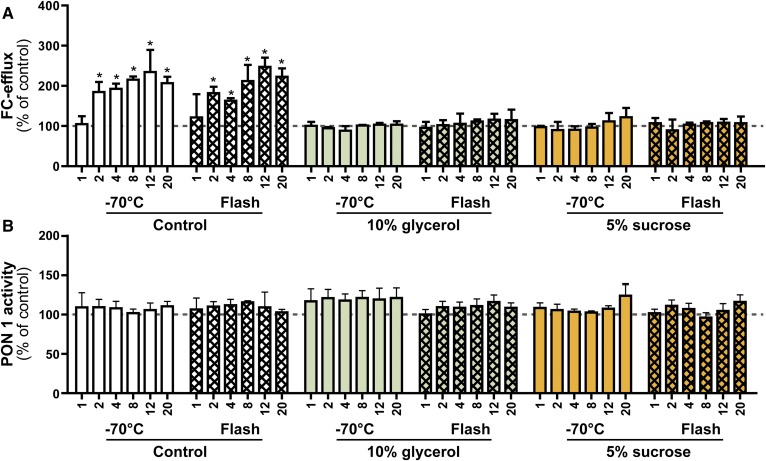
Functional analysis of flash-frozen HDL. HDL was isolated from the serum of four healthy donors by density gradient ultracentrifugation and pooled for functional analysis. HDL in the presence or absence of cryoprotectants (10% glycerol or 5% sucrose) was either frozen directly at −70°C or flash-frozen with liquid nitrogen and subsequently stored at −70°C. Aliquots were analyzed for their ability to promote cholesterol efflux (A) or for their HDL associated paraoxonase 1 activity (B). The dashed lines indicate the control value measured right after the isolation of HDL and were used for normalization to 100%. The labeling on the x axis indicates weeks of storage. Results represent the combined analysis of two independent experiments performed in triplicate. *P < 0.05 versus control.